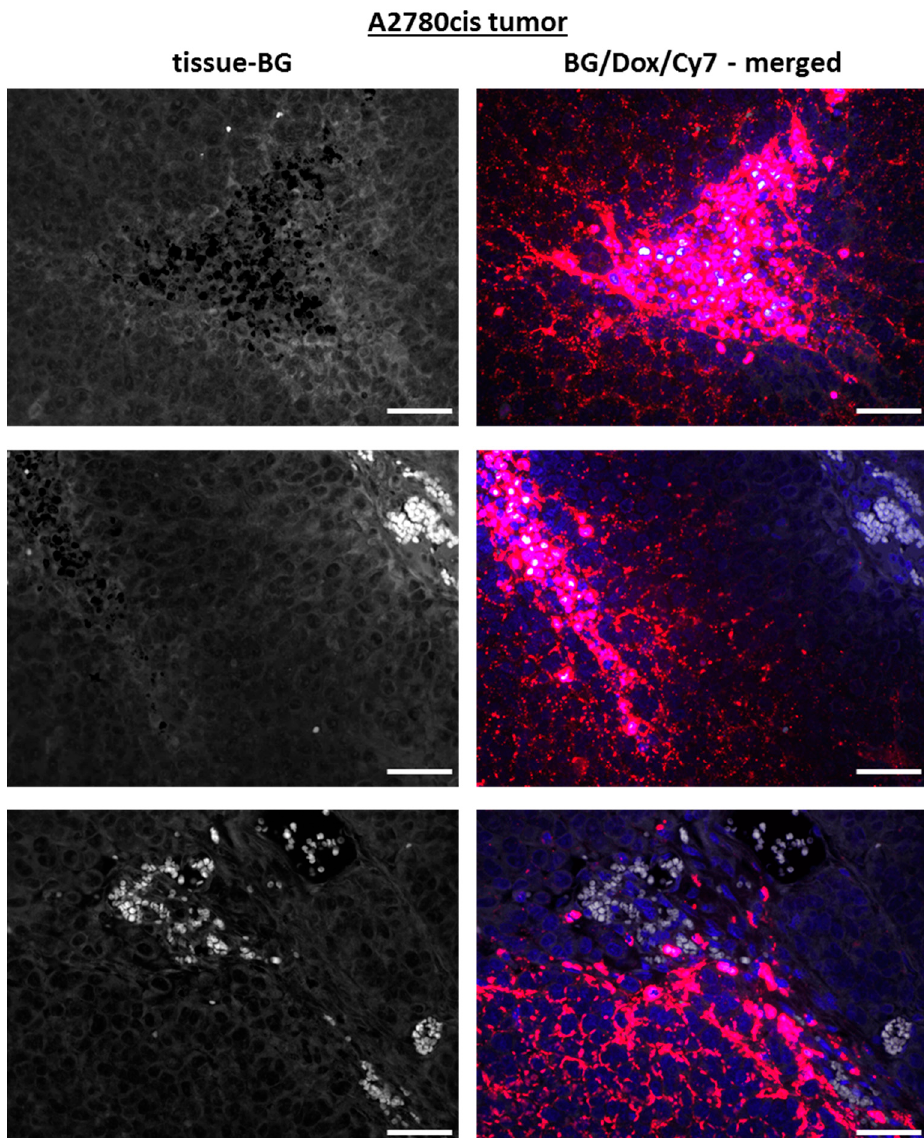
Figure 8. Specific pattern of distribution in the A2780cis tumor type. Depicted are three examples representing the main features of distribution found in the A2780cis tumor type 24 h after injection of the pHPMA-Dox-Cy7 conjugate. Images on the left side show the tissue background, respectively. On the right side, merged images of isolated Dox (blue) and polymer carrier (red) derived signals together with the tissue background are shown, respectively. Concentrated signals of co-localized Dox and polymer indicating the conjugate are confined to specific pre-damaged tissue structures from where the distribution appears to start and proceeds yielding typical patterns of cleavage and distribution in the periphery (upper and middle example). In contrast, areas of large intact vessels are characterized by cells with pure Dox accumulation lacking polymer-derived signals (middle example, upper right corner). Inconsistent distribution and cleavage of the conjugate occurs, resulting in completely different accumulation patterns, i.e., polymer associated or Dox only, within closely connected areas (bottom example). (Scale bar: 50 µm).